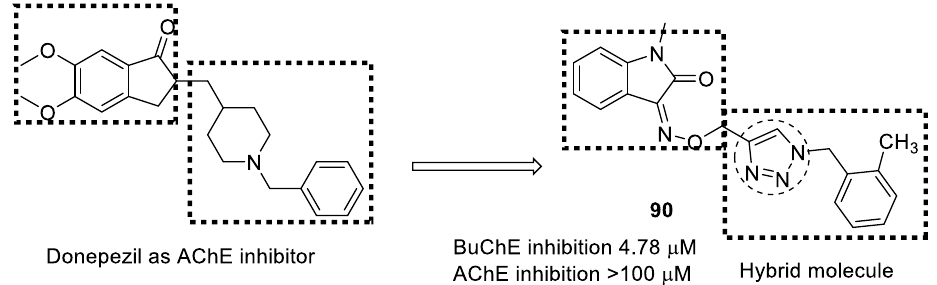
Figure 33. Chemical structure of donepezil–1,2,3-triazole hybrid. Bhagat et al., in 2021, used a rational drug design approach to synthesize two series of donepezil-based hybrid molecules using click chemistry following copper-catalyzed 1,4 cycloaddition reactions. The indanone moiety of donepezil was replaced with either coumarin or isatin scaffolds to improve its aromatic binding to PAS on AChE while, to further improve interactions with CAS, a 1,2,3-triazole moiety-bearing benzoyl group was incorporated in place of the piperidine ring and benzyl fragment. Compounds in both series showed significant in vitro inhibitory activity against eel AChE; however, coumarin– 1,2,3-triazole hybrids were noted to be more powerful inhibitors (IC 50 = 110–502 nM; 12.85–87.14% inhibition at 1 µ M) than isatin–1,2,3-triazole hybrids (IC 50 = 155–852 nM; 28.57–96.58% inhibition at 1 µ M). Compounds 91 (4-((1-(2-oxo-2-phenylethyl)-1 H -1,2,3-triazol- 4-yl)methoxy)-2 H -chromen-2-one) and 92 (1-((1-(2-(4-chlorophenyl)-2-oxoethyl)-1 H - 1,2,3- triazol-4-yl)methyl)-5-fluoroindoline-2,3 – dione), the two most potent AChEIs (IC 50 =110 and 155 nM, respectively), were found to be mixed inhibitors of AChE, and they preferentially bind to the free enzyme instead of the enzyme – substrate complex (Figure 34). These compounds showed similar binding interactions to donepezil and were stable in the active site, as revealed by molecular dynamic simulations. However, their inhibi- tory activity was slightly weaker than the parent drug donepezil (IC 50 = 42 nM; 99.01 % inhibition at 1 µM). SAR studies revealed that the presence of an electronegative group such as F, Cl, or NO 2 on the benzoyl ring improves AChE inhibition. These two hit/lead molecules may be further optimized to obtain potent AChEIs [123]. Figure 34. Chemical structure of donepezil (coumarin/isatin) – 1,2,3-triazole hybrids. 3.16. Benzodiazepine – 1,2,3-Triazole Hybrids Benzodiazepine – 1,2,3-triazole conjugate has shown more selectivity to BuChE over AChE when evaluated for ChE inhibition. The synthesized derivative 3,3-dimethyl-11-(3- ((1-(4-nitrobenzyl)-1 H -1,2,3-triazol-4-yl) methoxy) phenyl)-2,3,4,5,10,11-hexahydro-1 H - dibenzo[ b,e ][1,4]diazepin-1-one ( 93 ) inhibited BuChE with an IC 50 value of 0.2 µM (Figure 35). The 93 showed a potent inhibitory effect against Aβ self -aggregation as compared with donepezil. The BuChE inhibitory activity was supported by docking studies, as